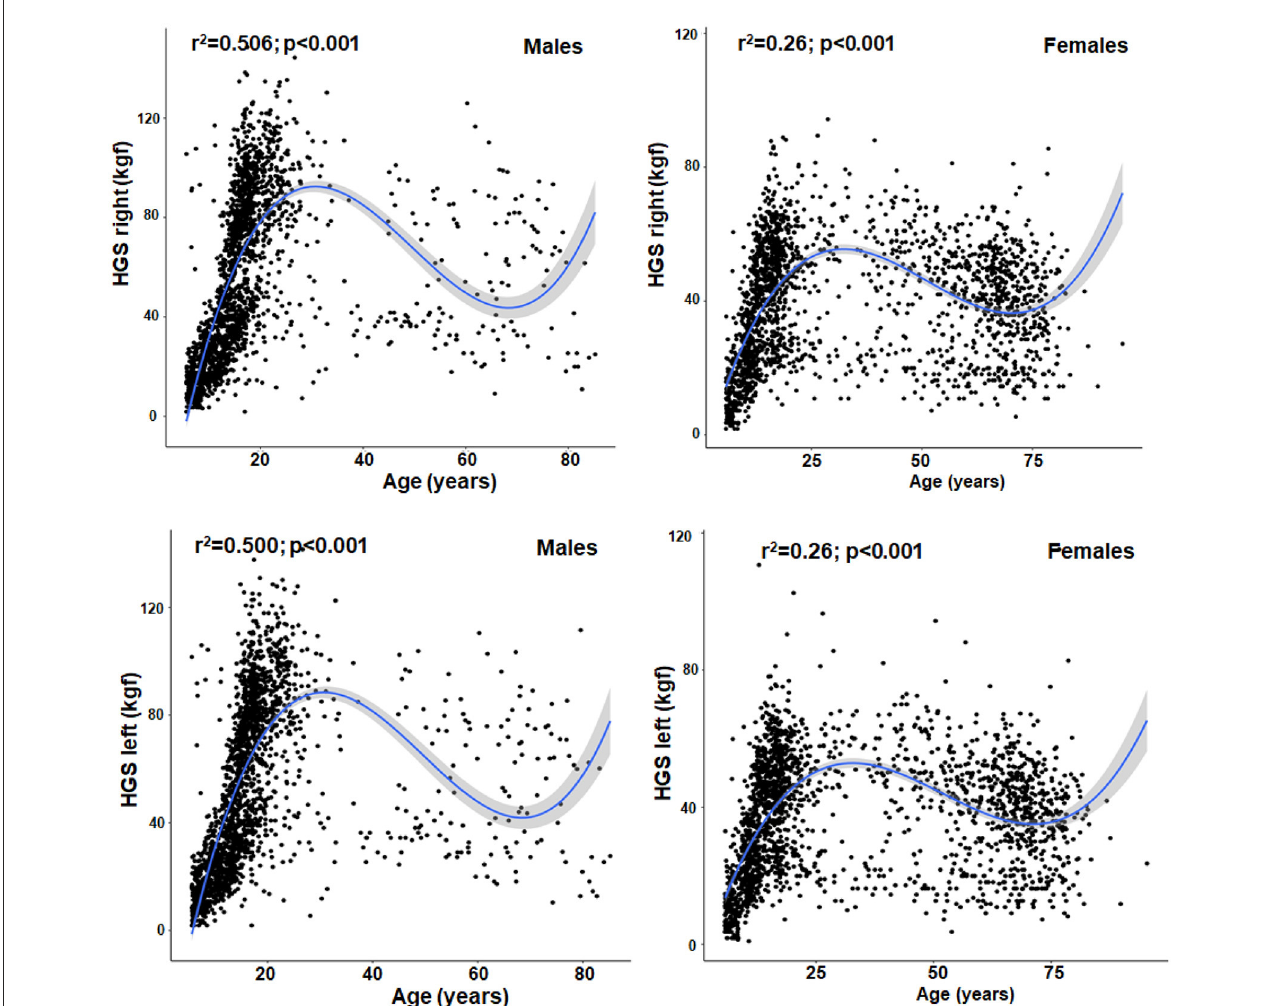
FIGURE1 Non-linear relationship (cubic) between chronological age with HGS in both hands and both sexes from 6 to 80 years of age.